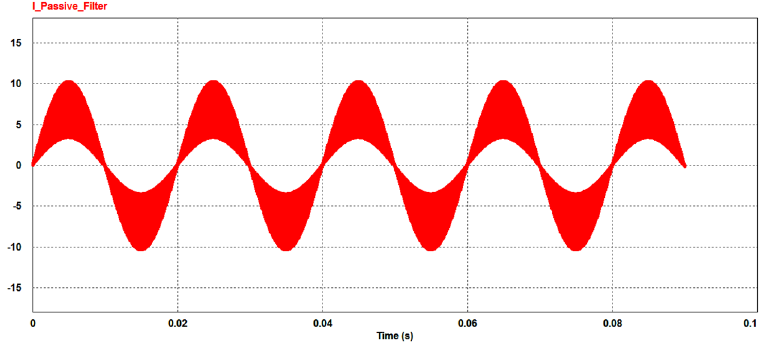
Figure 12. Input current waveform of an IH system with a passive filter.